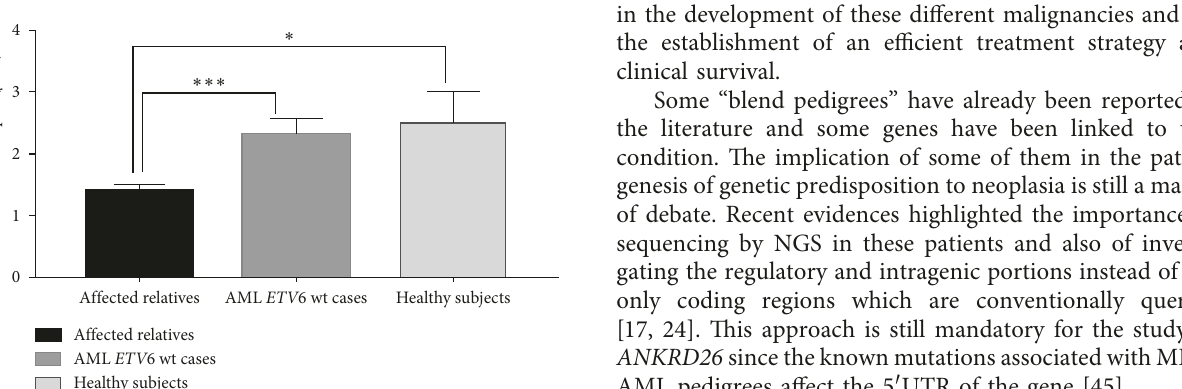
Figure 3: Quantification of ETV6 transcripts by dPCR. The quantification was performed on PBMCs RNA. ETV6 transcript levels were normalized for GAPDH transcript levels and expressed as ratio. Black block: affected relatives; Dark grey block: AML wt- ETV6 cases; Light grey block: healthy subjects. Affected